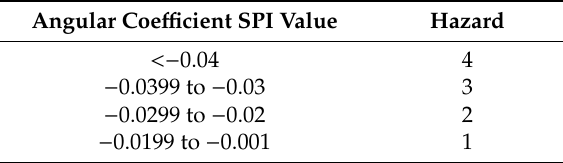
Table 11. Precipitation shift hazard (Hp) values, Hp varies from 1 (lower) to 4